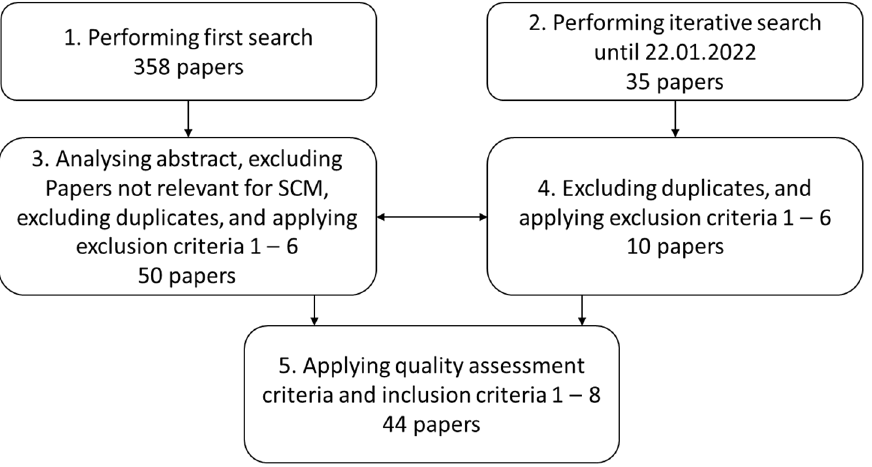
Figure 2. Process flow of paper selection.